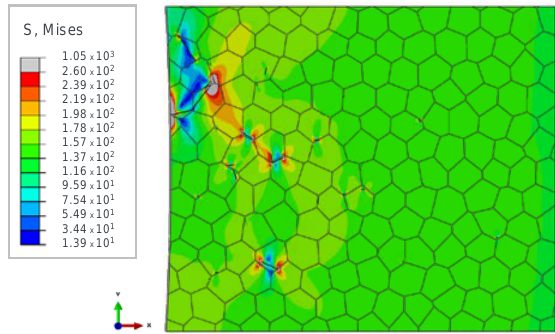
Figure 9. Damaged microstructural model of the Fe 99.9% at the end of the crack initiation stage, under 75 MPa loading stress amplitude.